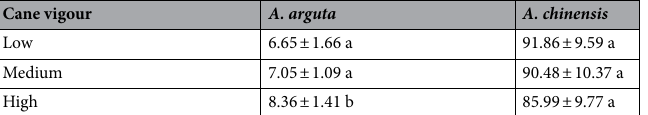
Table 3. Average fruit weight of A. arguta and A. chinensis in g (mean ± SE) after picking. Mean values followed by the same letter within a column do not differ significantly.